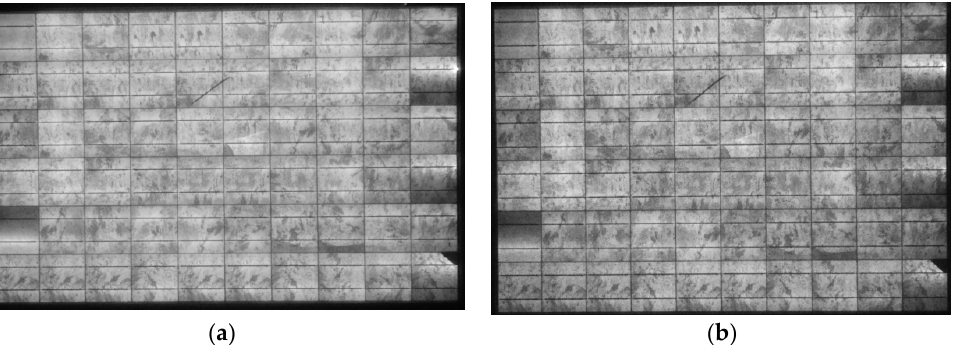
Figure 15. ( a , b ). ODT pc-Si module no1 EL images at bias ( a ) V = 42.5 and ( b ) V = 39.5 V. In ( b ), a bright EL spot appears at the edge of the cell in the right column due to a problem in the passivation, whereas in ( a ), the passivation problem is evident in the same cell.